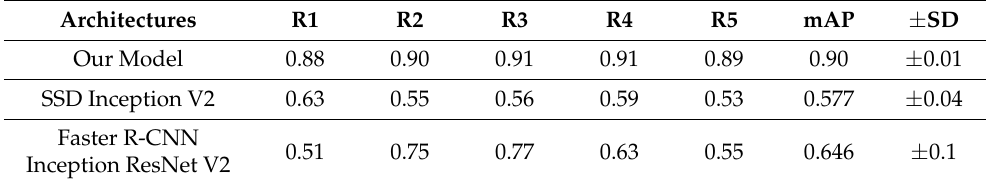
Table 5. Comparison of mAP metrics.